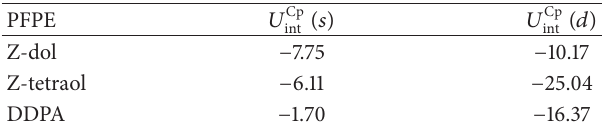
Table 5: The counterpoise corrected interaction energies for lubricant-GOC clusters for single-layer (denoted as ( 𝑠 )) and double- layer (denoted as ( 𝑑 )) graphene. All values are in